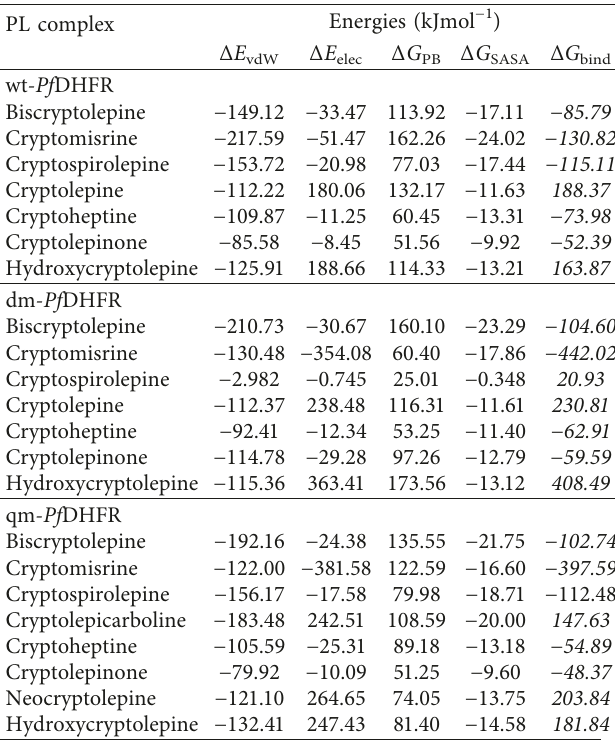
Table 6: Thermodynamics of binding of selected C. sanguinolenta alkaloids- Pf DHFR complexes obtained from the entire duration (50ns) of the molecular dynamics’ simulation PL